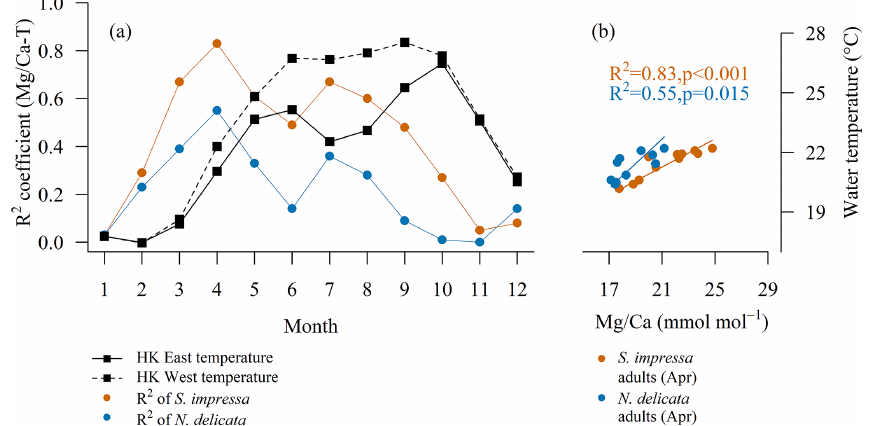
Figure 3. (a) Monthly temperature calibrations to Mg / Ca of S. impressa ( η = 7) and N. delicata ( η = 3) for adult ostracod. (b) The calibra- tions for S. impressa and N. delicata for April are Mg / Ca S. impressa = 2 . 8 · T − 39 . 2 and Mg / Ca N. delicata = 1 . 6 · T − 15 . 7.